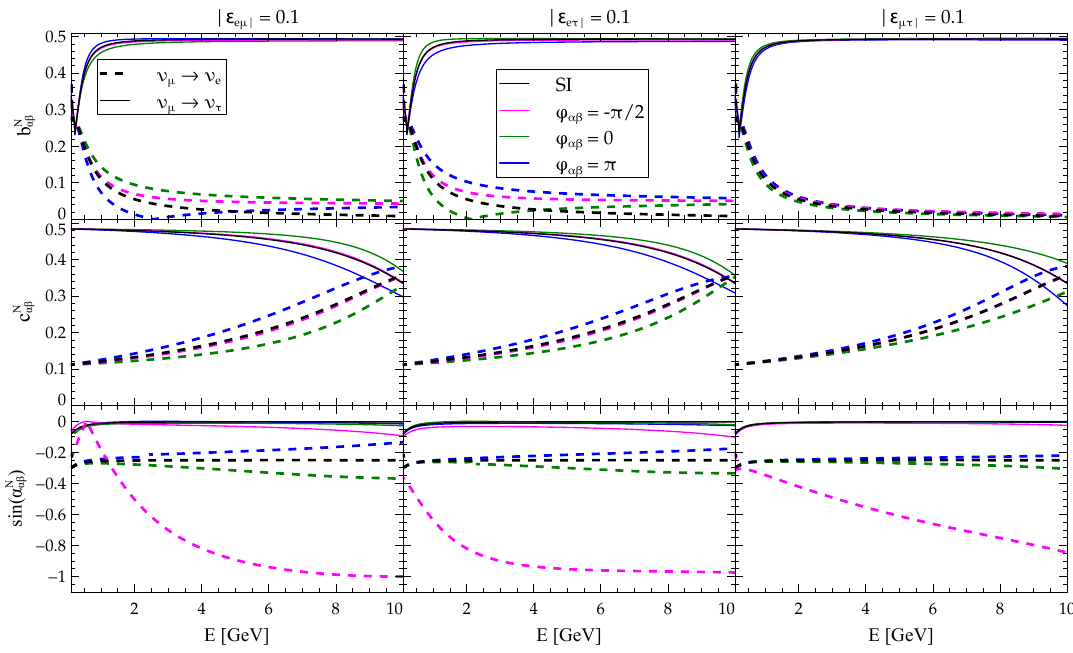
Figure 6 . Evolution of the LUT parameters b N energy for the ν µ → ν e and ν µ → ν τ channels for the SI and NSI case with different sizes of the couplings and their